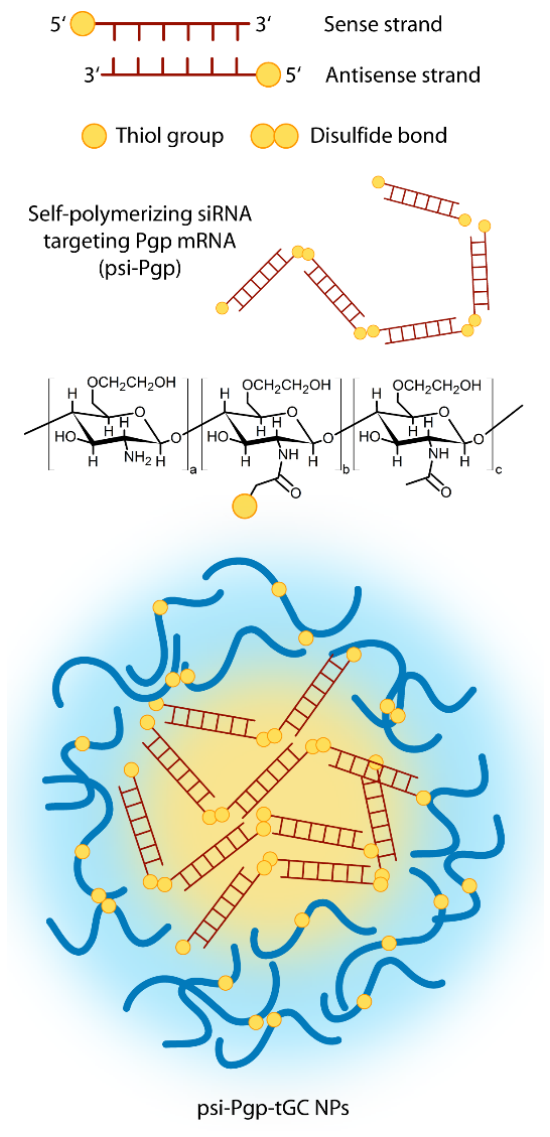
Figure 7. CS-based delivery for siRNAs proposed by Ji Young Yhee et al.